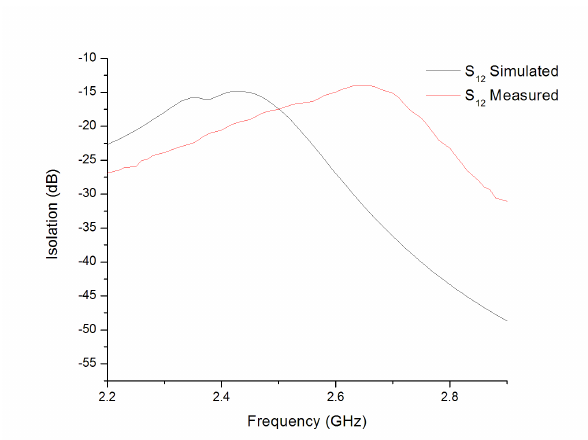
Figure 5: Simulated and measured Isolation (dB)